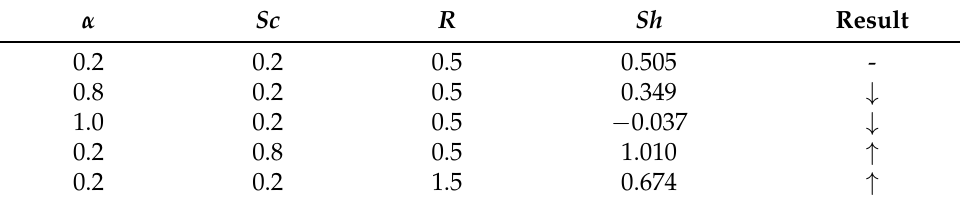
Table 2. Sherwood number with various values of parameters.